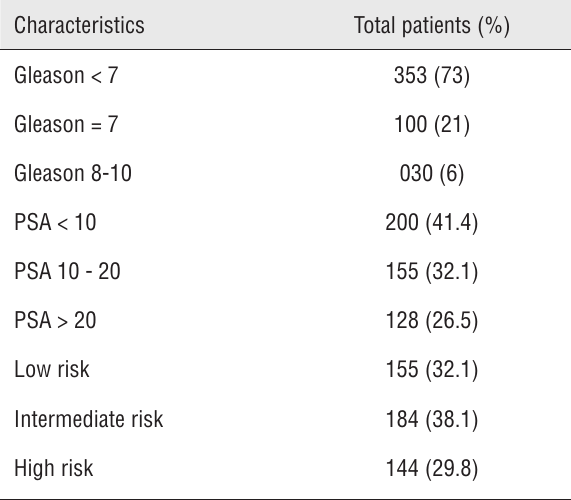
Table 1 - Patients characteristic before treatment.